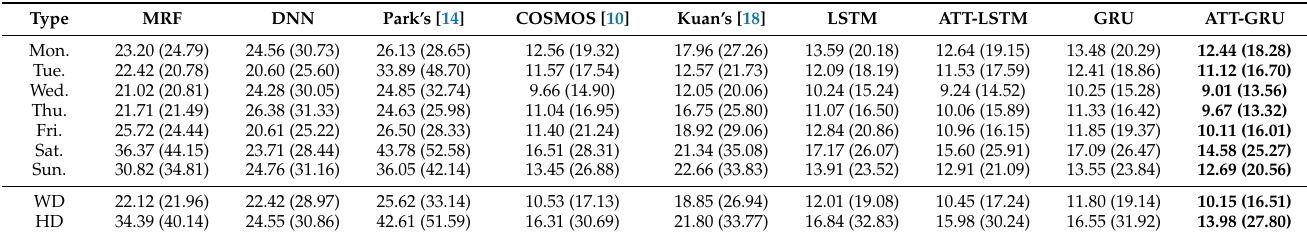
Table 11. MAPE (CVRMSE) comparison by date types for Building 2. WD and HD denote weekdays and holidays, respectively.